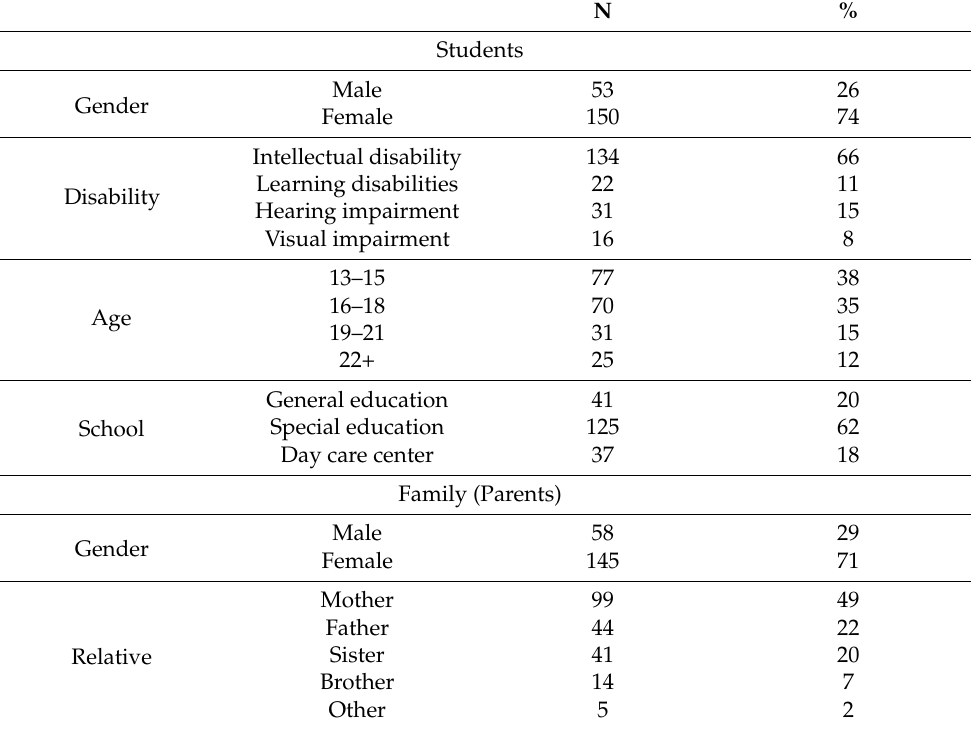
Table 1. Participant